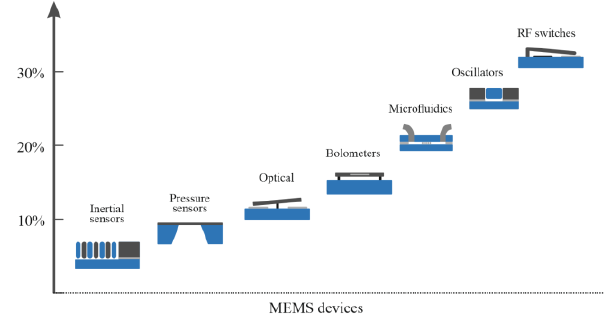
Fig. 2. The average annual growth rate of the main types of MEMS.